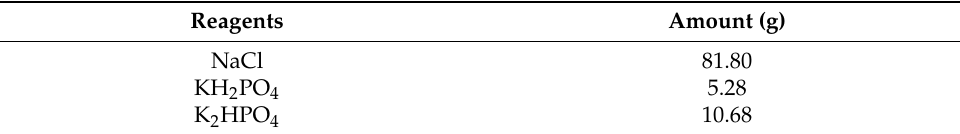
Table 2. Reagents used to make 1 L of 10 × PBS.